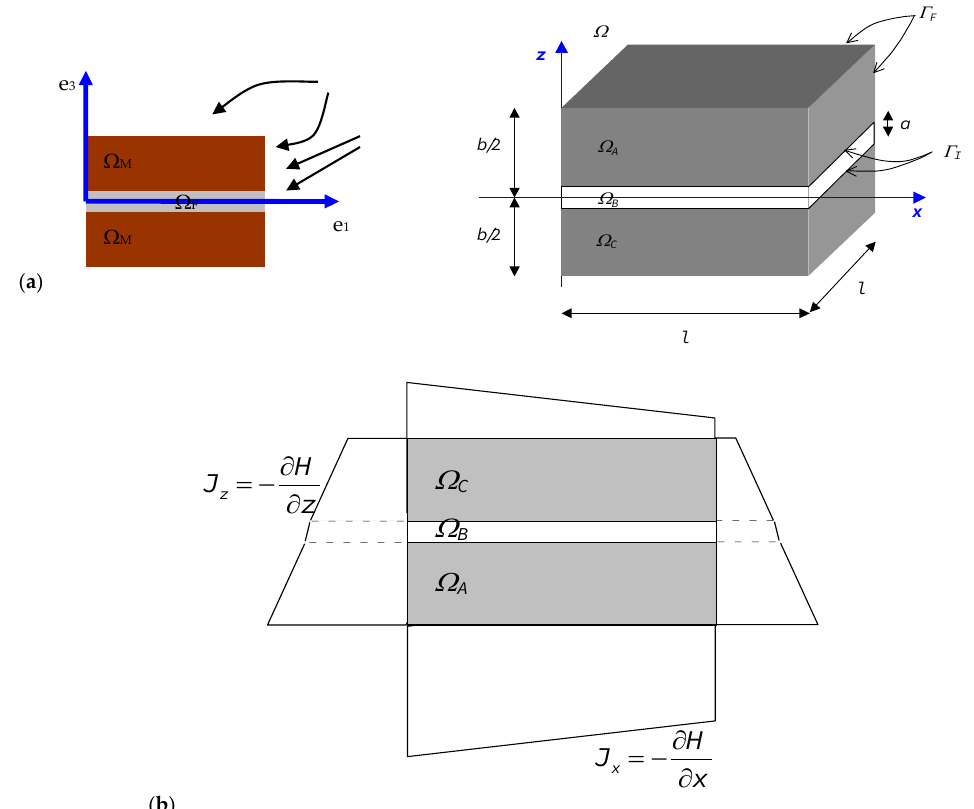
Figure 11. ( a-left ): Schematic of a “unit” block Ω containing a single “fracture” Ω F sandwiched be- tween two layers of porous matrix Ω M . ( a-right ): The fractured matrix block, with explicit indication of fracture aperture and matrix layers thicknesses. ( b ): Two-dimensional view of the piecewise linear head conditions, corresponding to piecewise constant gradient J along the boundaries